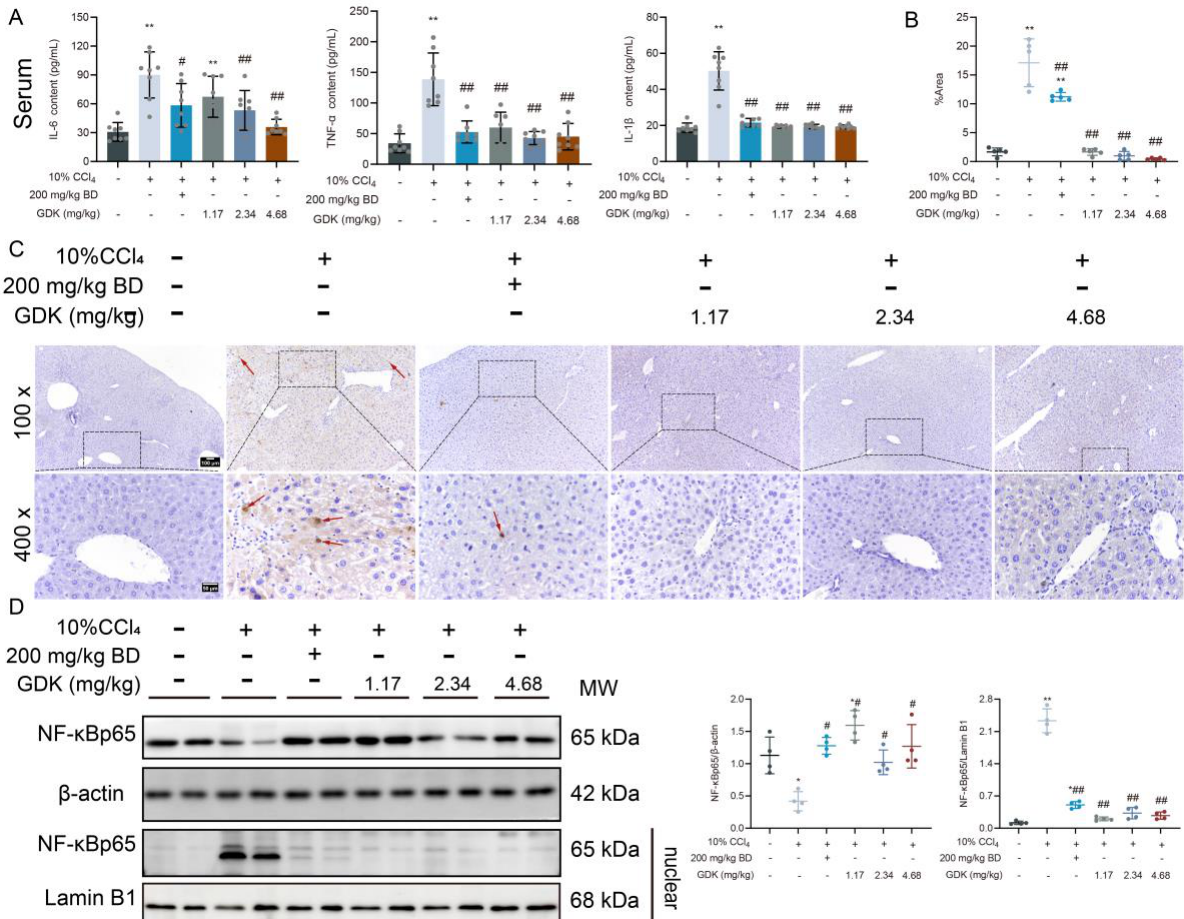
Figure 3. GDK reduces inflammation in CCl 4 -induced chronic liver injury mice. ( A ) Serum IL-6, TNF- α , and IL-1 β levels in indicated mice (n = 8 per group). ( B , C ) TUNEL analysis of the liver samples of indicated mice. Red arrow: Positive area. ( D ) Western blot analysis of total and nuclear NF- κ Bp65 in the liver of indicated mice. Lamin B1 and β -actin served as loading controls (n = 3 per group). * p < 0.05, ** p < 0.01, # p < 0.05, and ## p < 0.01.